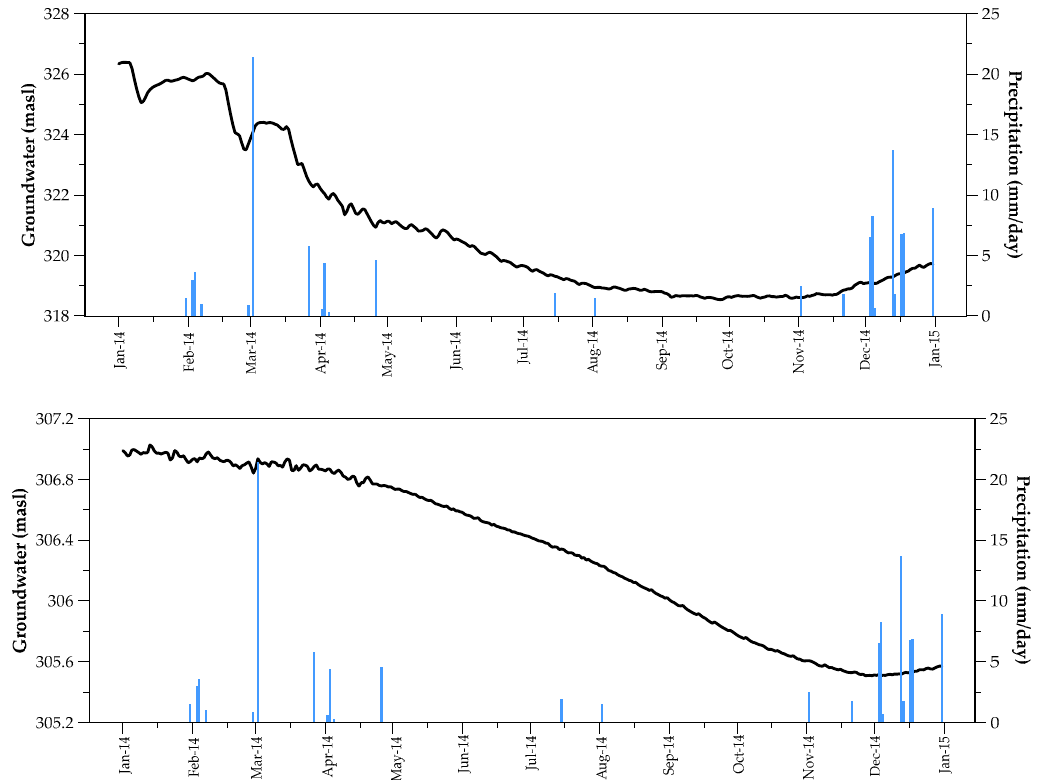
Figure 8. Behavior of the static levels in the wells located in the Calafia ( above ) and El Porvenir ( below ).